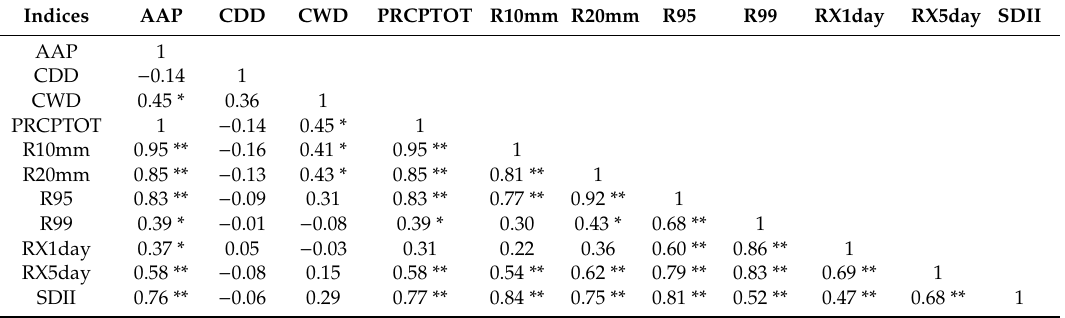
Table 4. Correlation coe ffi cients between annual average precipitation (AAP) and the extreme precipitation indices in the